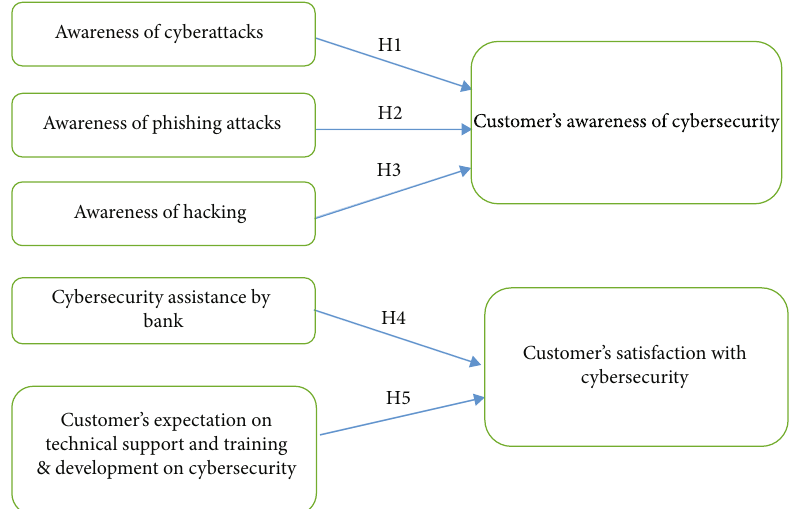
Figure 1: Conceptual framework on customer ’ s awareness of cybersecurity and conceptual framework on customer ’ s satisfaction with